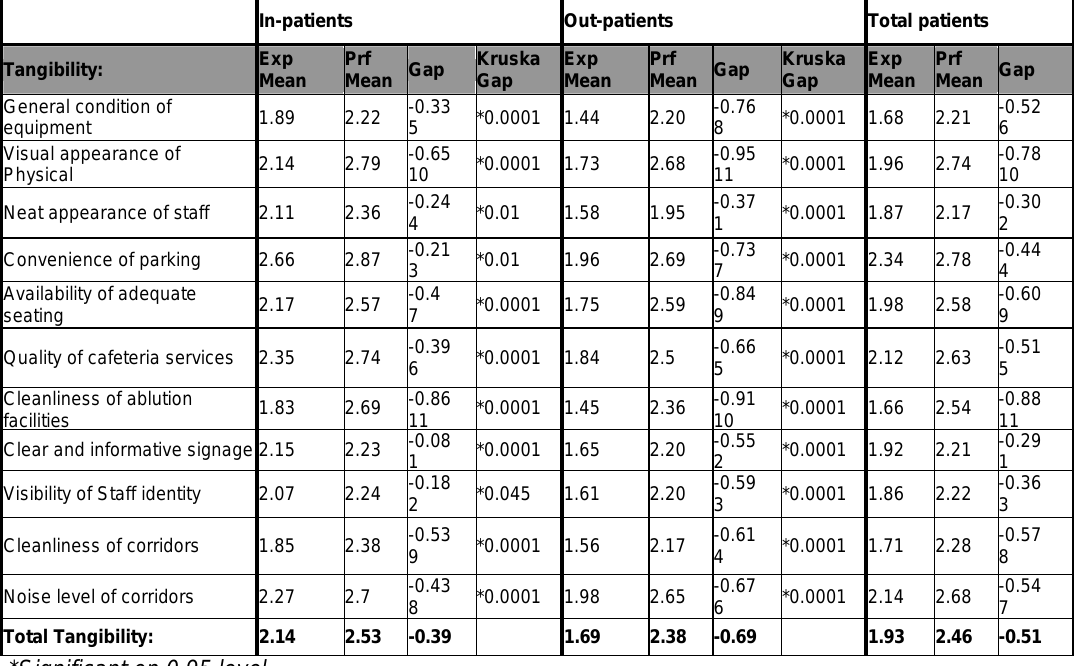
Table 5: Test for significant differences between expectations and perceived performance of tangibility